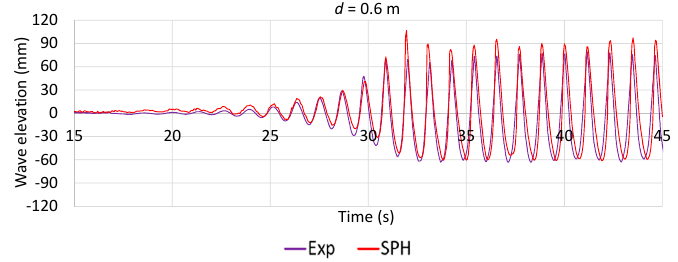
Figure 13. Comparison of wave elevation with box-shape obstacle.